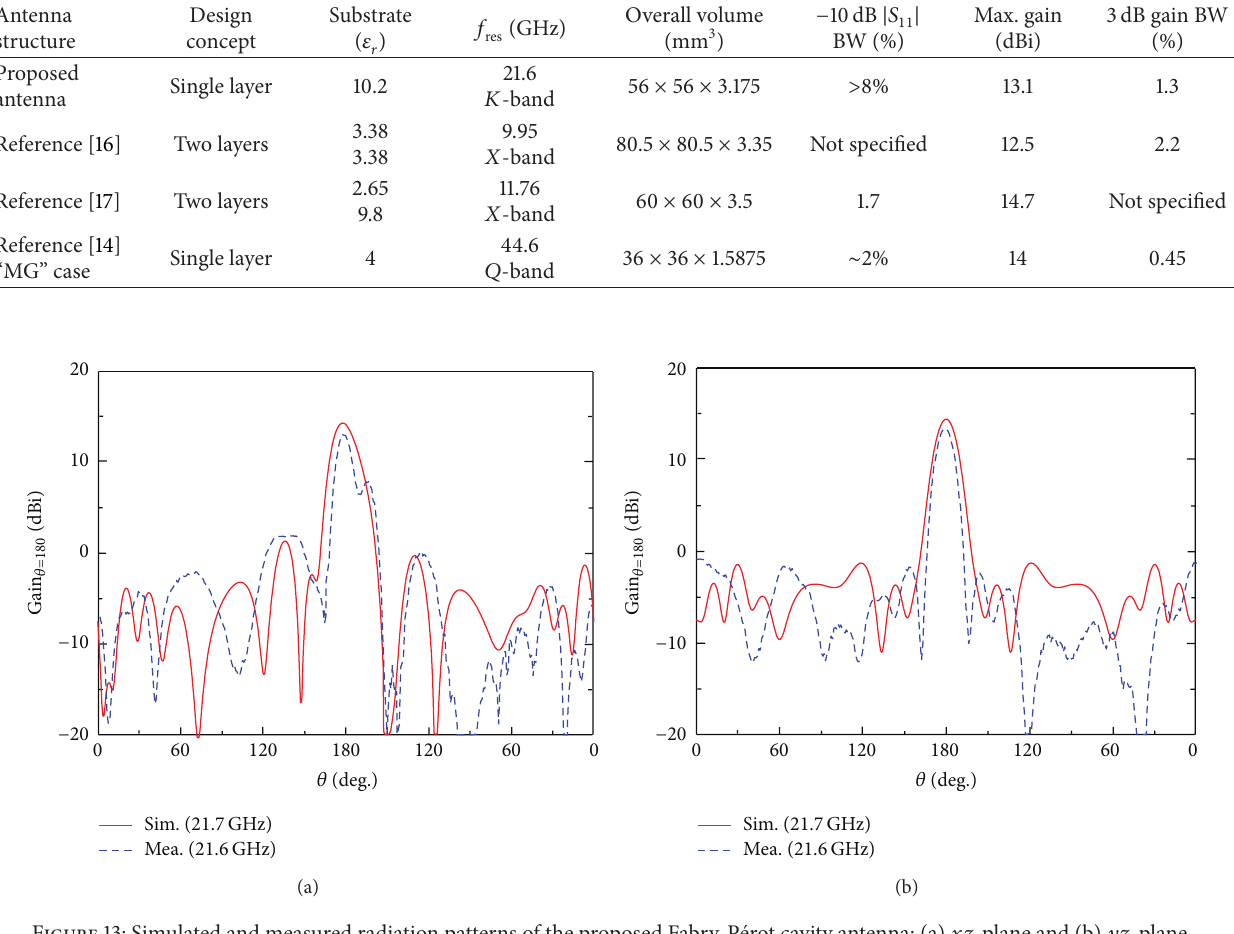
Figure 13: Simulated and measured radiation patterns of the proposed Fabry-P´erot cavity antenna: (a) 𝑥𝑧 -plane and (b) 𝑦𝑧